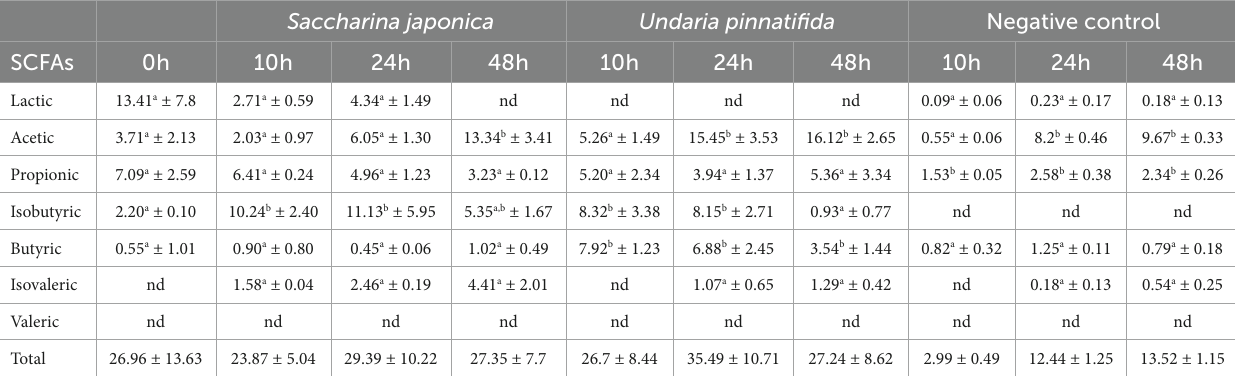
TABLE 2 Changes in lactate and short-chain fatty-acid (SCFA) concentrations (mM) in the samples obtained for each substrate after fecal fermentation assays at 0, 10, 24, and 48